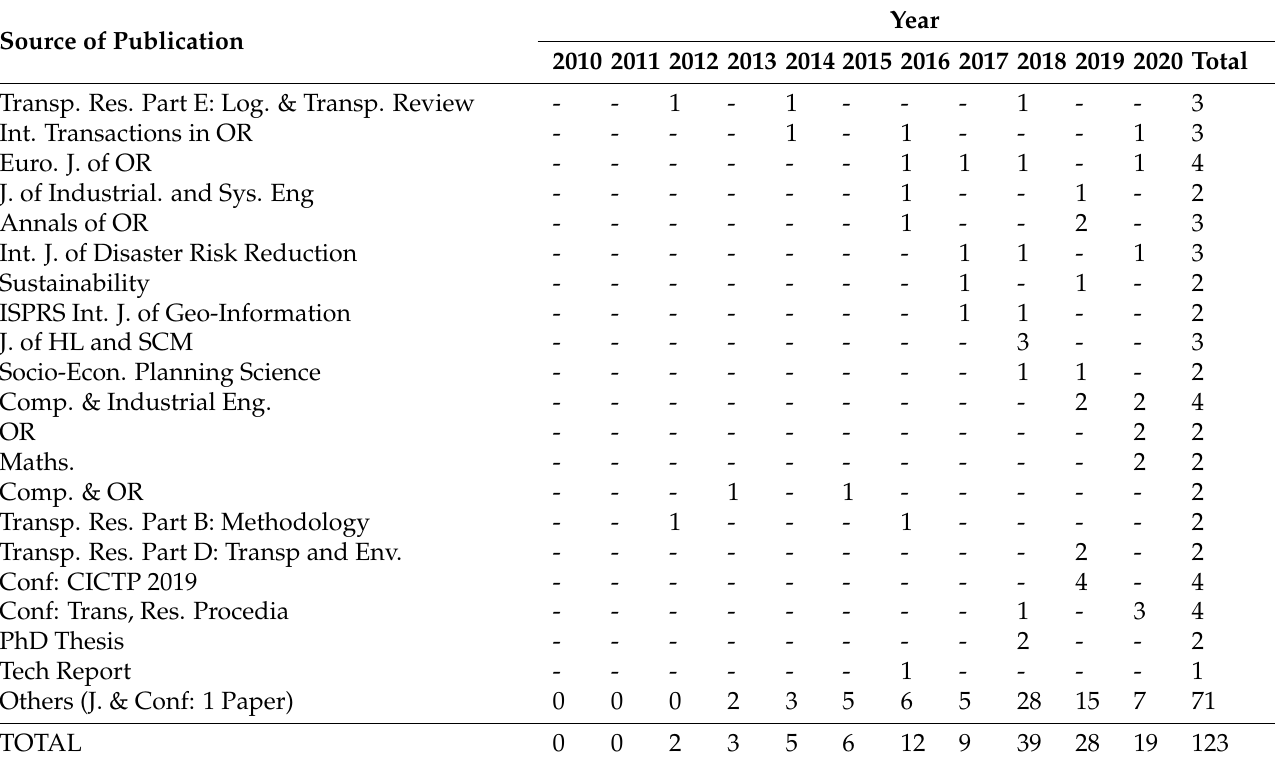
Figure 3. Distribution of Papers Based on Different Publication. Table 2. Distribution of Papers Based on Different Publications Over the